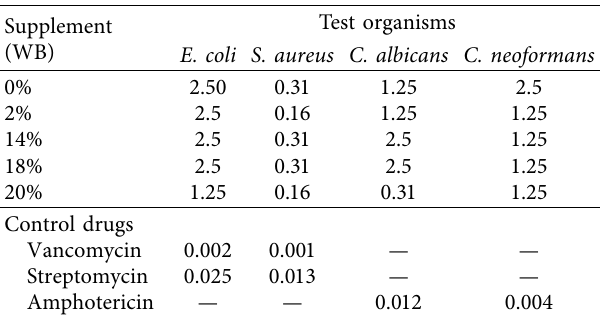
Table 1: Minimum inhibitory concentration (MIC) (mg/ml) of methanol extract of P . ostreatus mushroom grown on sugar cane tops supplemented with varying levels of wheat bran.